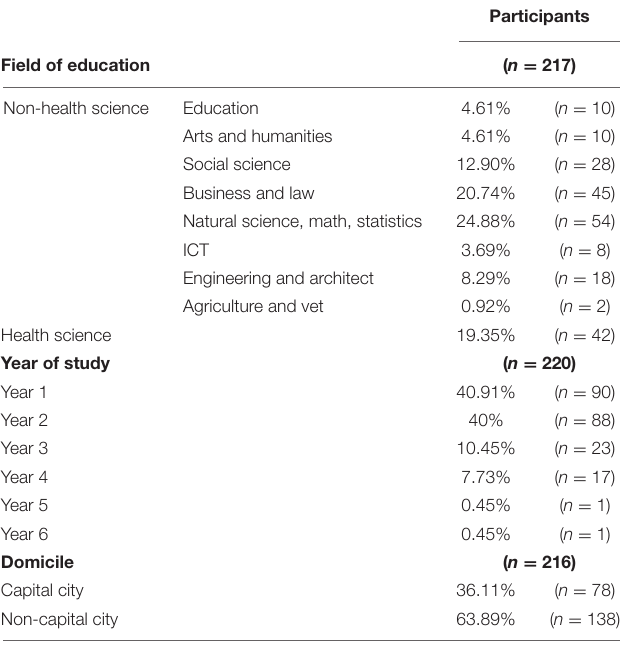
TABLE 2 | Participant characteristics and demographic